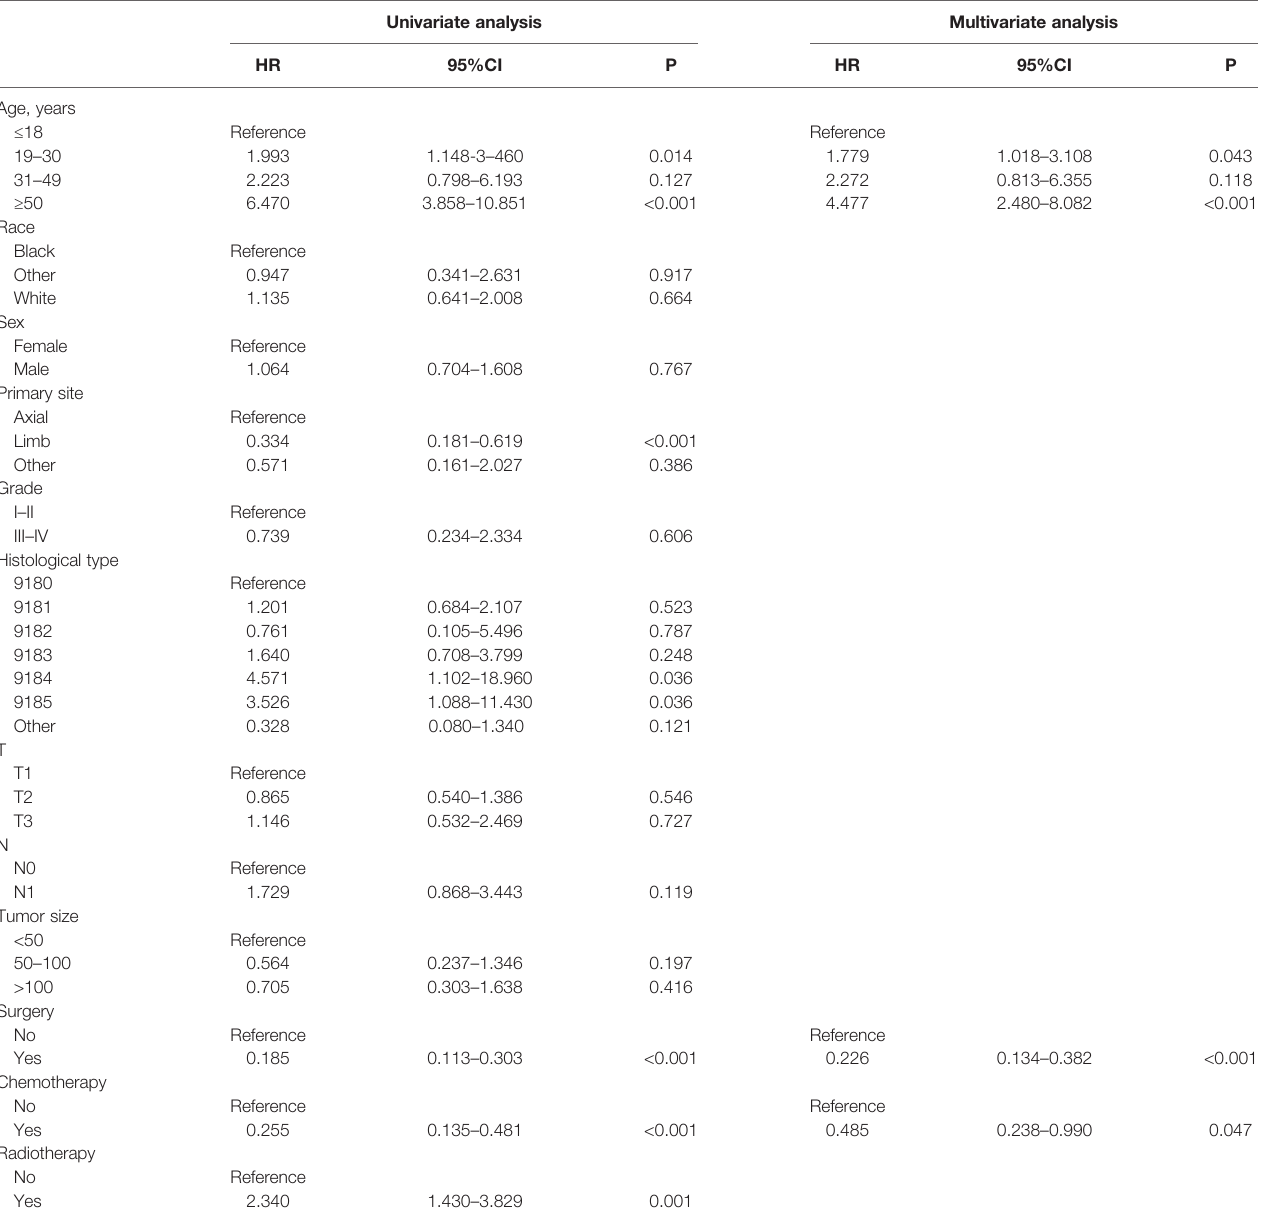
TABLE 4 | Univariate and multivariate Cox analyses in osteosarcoma patients with DM. Univariate analysis Multivariate